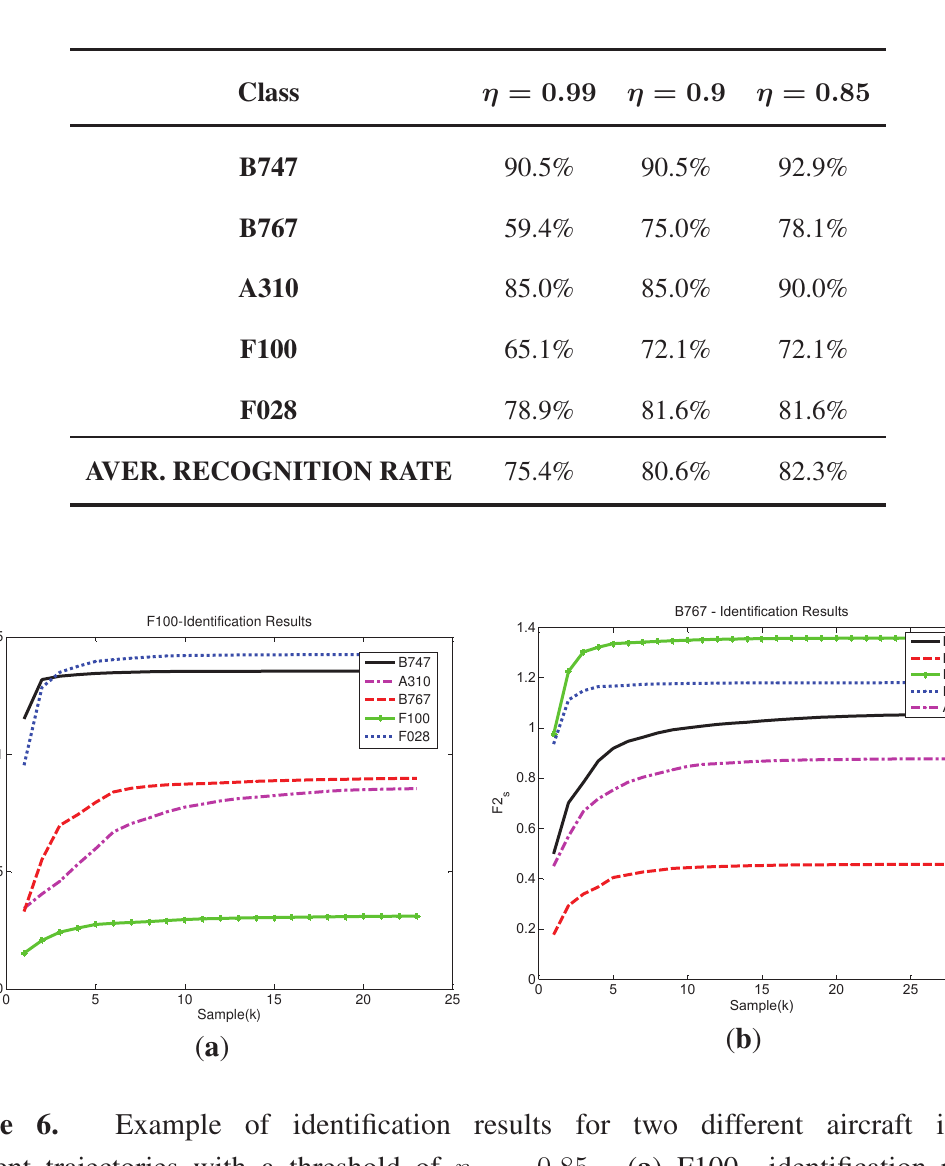
Table 2. Average recognition rates with F 2